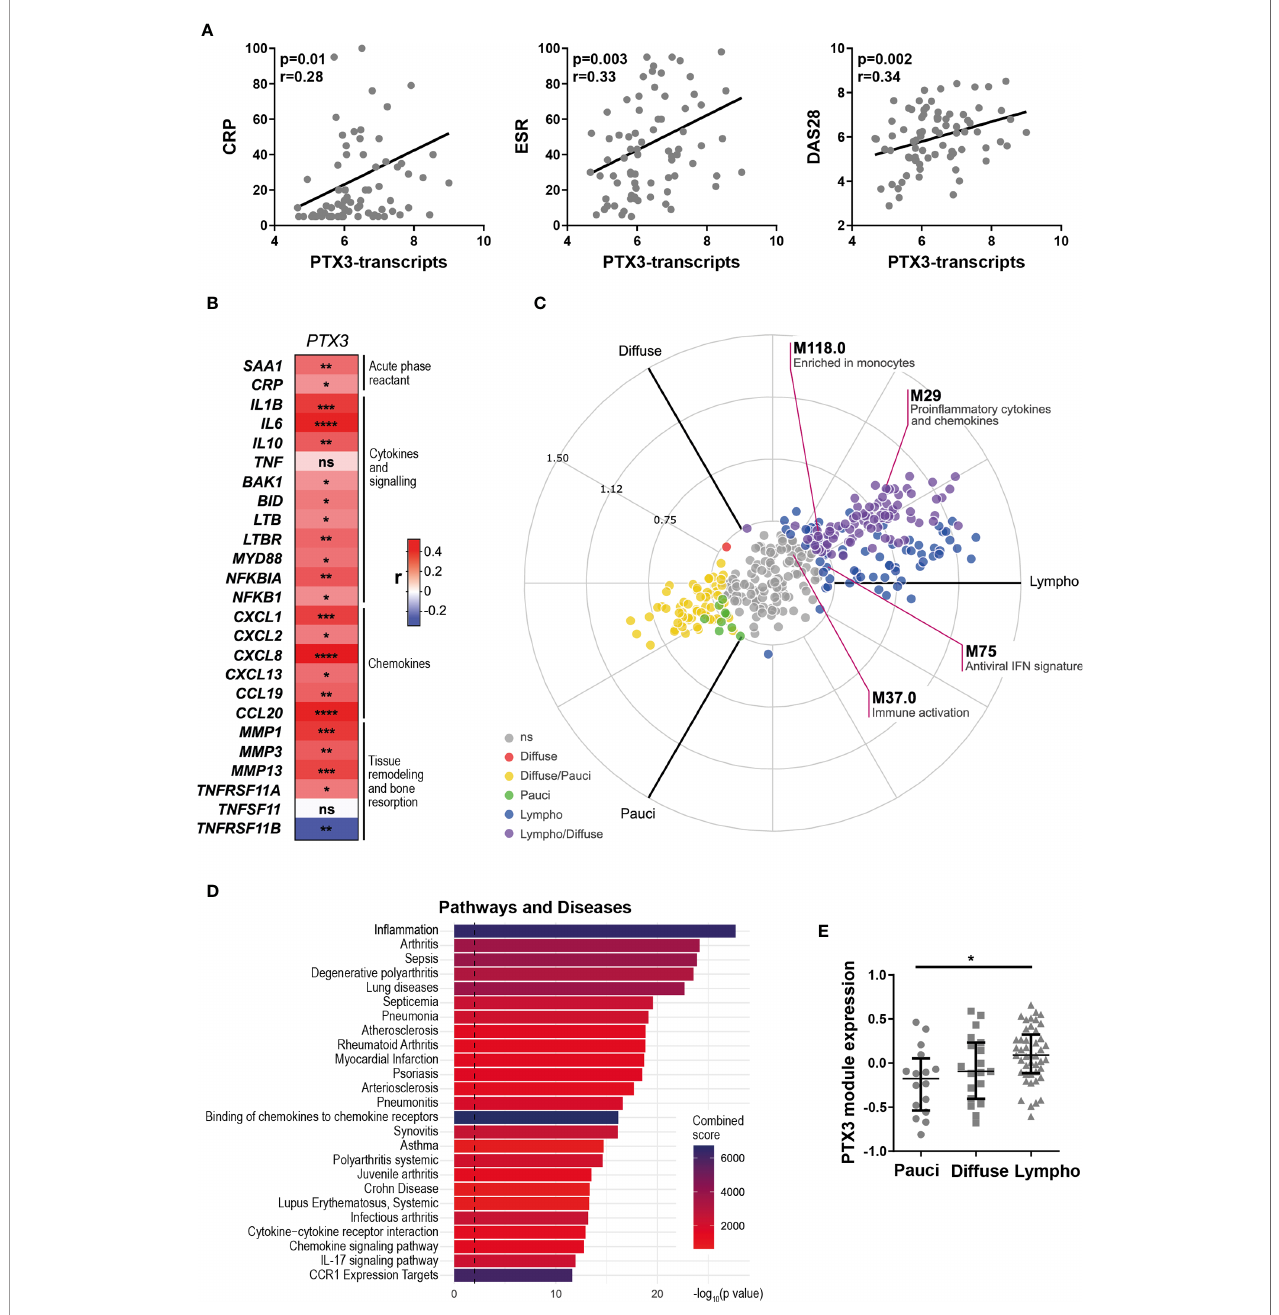
FIGURE 2 | Synovial PTX3 gene expression correlates with disease activity and local in fl ammation. (A) Correlation between synovial transcript levels of PTX3 at baseline assessed by bulk RNA-seq and CRP, ESR and DAS28. (B) Heatmap representing the correlation between PTX3 synovial transcript levels at baseline and acute phase reactants, selected chemokines, cytokines and related signaling pathways mediators involved in in fl ammation, tissue remodeling and bone resorption. The red/blue scale represents the spearman r coef fi cient. *p < 0.05, **p < 0.01, ***p < 0.001, ****p < 0.0001. (A, B) p-values and r coef fi cients were calculated using Pearson correlation test. (C) 2D polar plot of transcript modules containing PTX3 in synovial tissue presenting a lympho-myeloid (lympho), diffuse-myeloid (Diffuse), and pauci-immune fi broid (Pauci) pathotypes (4). Different colors show pairwise comparisons between the three pathotypes: upregulation in one group only (Diffuse: red, Pauci: green and Lympho: blue) or in two groups (Diffuse/Pauci: yellow, Lympho/Diffuse: purple). (D) Pathways and diseases gene set enrichment analysis of the PTX3 module, composed of the 30 genes encoding for the protein integrated in the PTX3 string network, performed using the R interface to the EnrichR database (https://CRAN.R-project.org/package=enrichR). (E) PTX3 module expression in RA synovium classi fi ed as pauci-immune (n = 16), diffuse-myeloid (n = 20) and lympho-myeloid (n = 43). Data are represented as median +/- interquartile range. * = p < 0.05, as assessed by the Kruskal – Wallis test with Dunn ’ s post-test; ns, non-signi fi